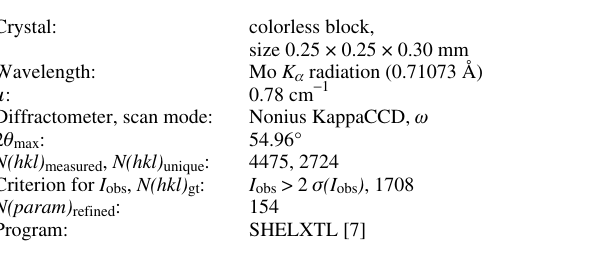
Table 1. Data collection and